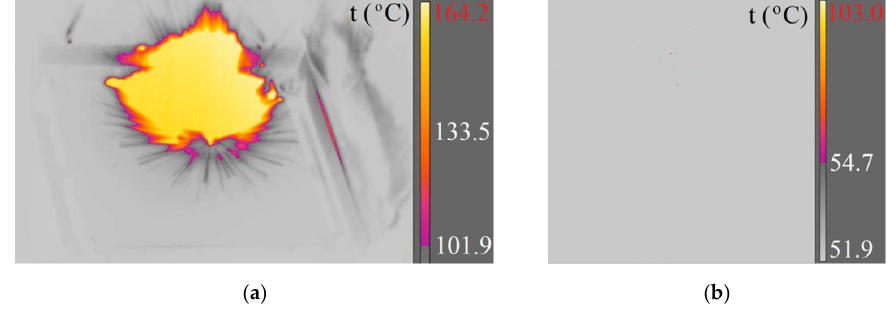
Figure 4. Recording of a 7.62 × 51 mm SWISS PAP projectile fired from a 7.62 × 51 mm ballistic